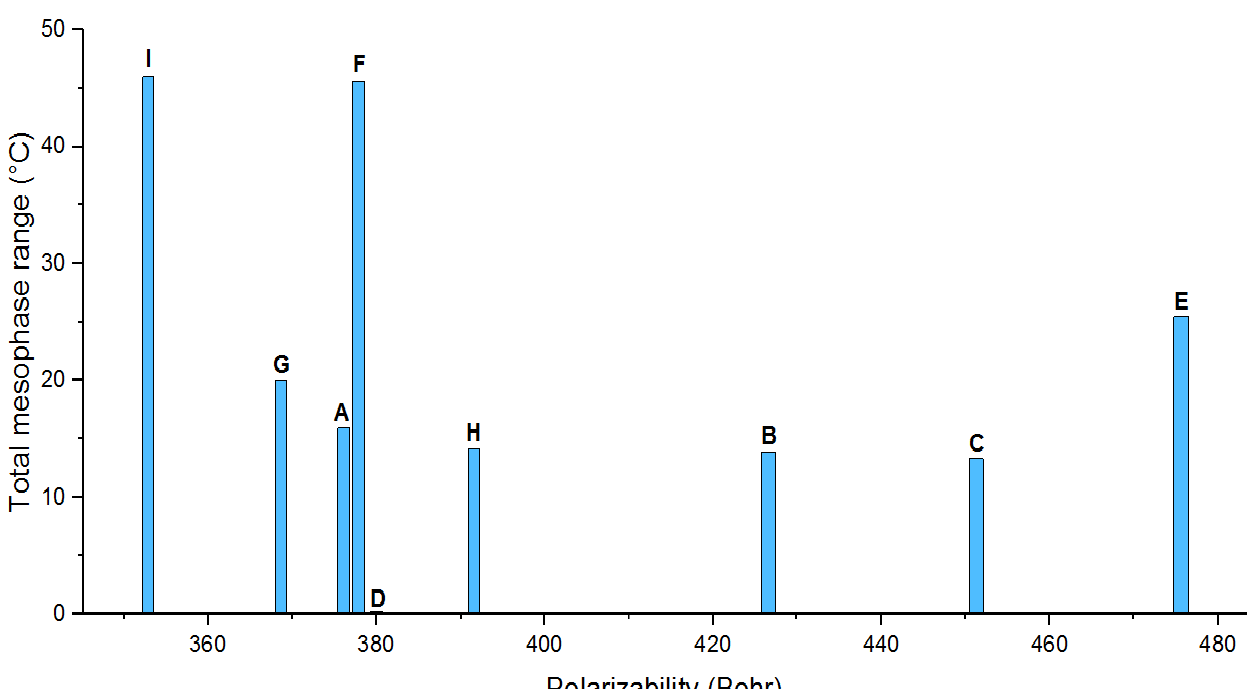
Figure 8. Graph of mesophase range versus polarizability of A , B , C , D , E , F , G , H , and I com- pounds.